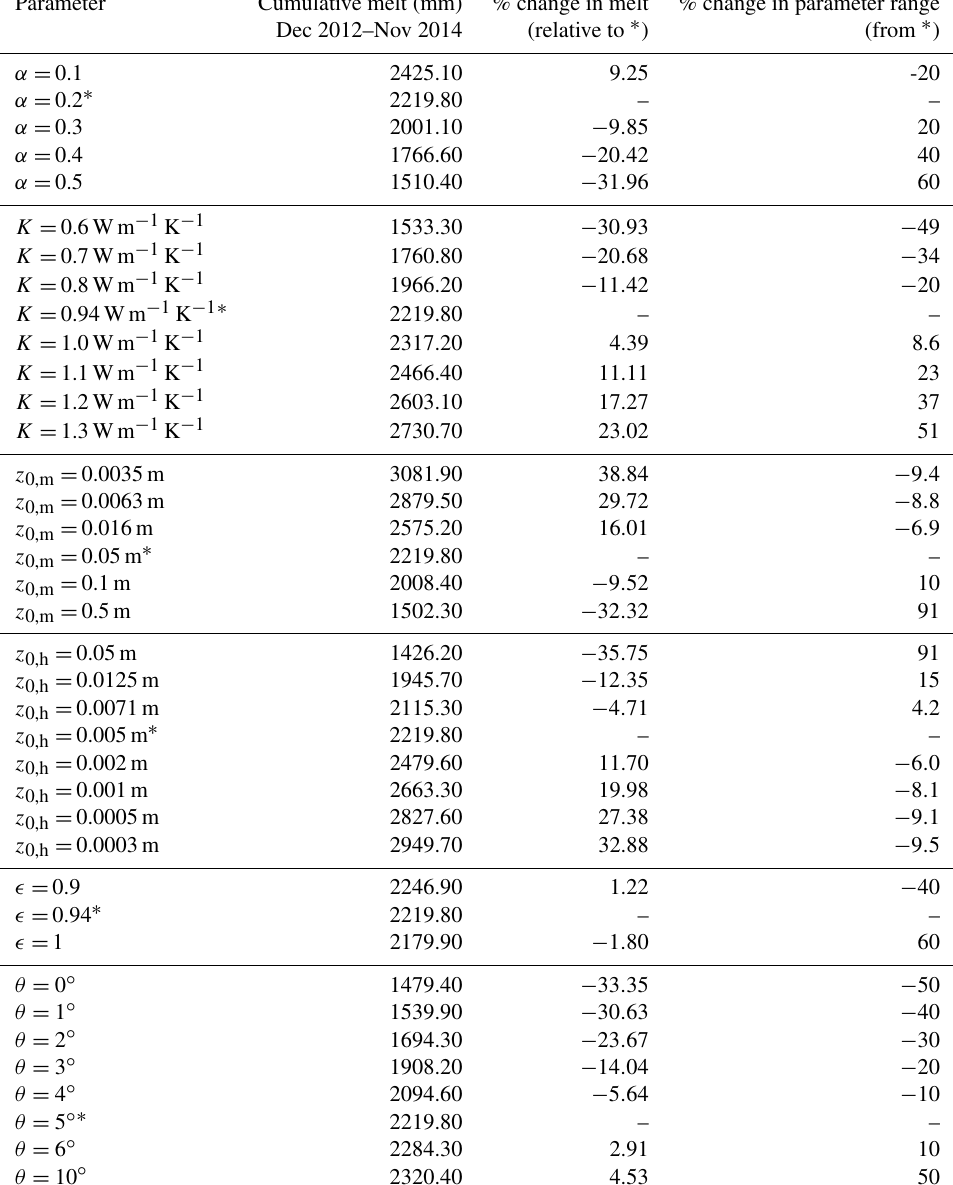
Table 4. Summary of sensitivity tests performed on ISBA-DEB on albedo ( α ), thermal conductivity ( K ), roughness lengths for momentum ( z 0,m ) and heat ( z 0,h ), emissivity ( (cid:15) ), and slope ( θ ). An asterisk indicates values that are used in Sect. 5.1 and for the partially saturated scenario in Sect. 5.2. Each parameter was varied while the others were held at their values with an asterisk. These values provide the basis of comparison in columns 3 and